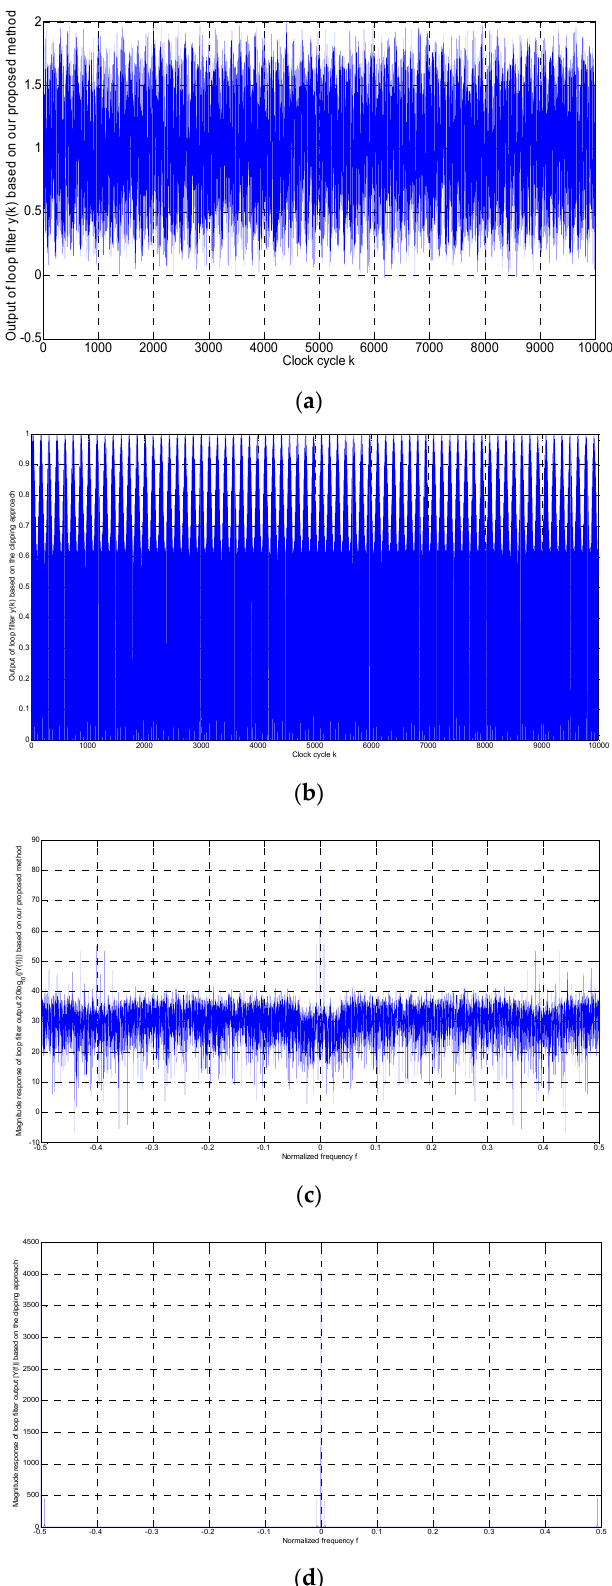
Figure 6. ( a ) Output of the loop filter when u ( k ) = 0.24sin ( 0.0142 π k ) for k ≥ 0 under our proposed control strategy. ( b ) Output of the loop filter when u ( k ) = 0.24sin ( 0.0142 π k ) for k ≥ 0 under the clipping control strategy [7]. ( c ) Magnitude response of the output of the loop filter when u ( k ) = 0.24sin ( 0.0142 π k ) for k ≥ 0 under our proposed control strategy. ( d ) Magnitude response of the output of the loop filter when u ( k ) = 0.24sin ( 0.0142 π k ) for k ≥ 0 under the clipping control strategy